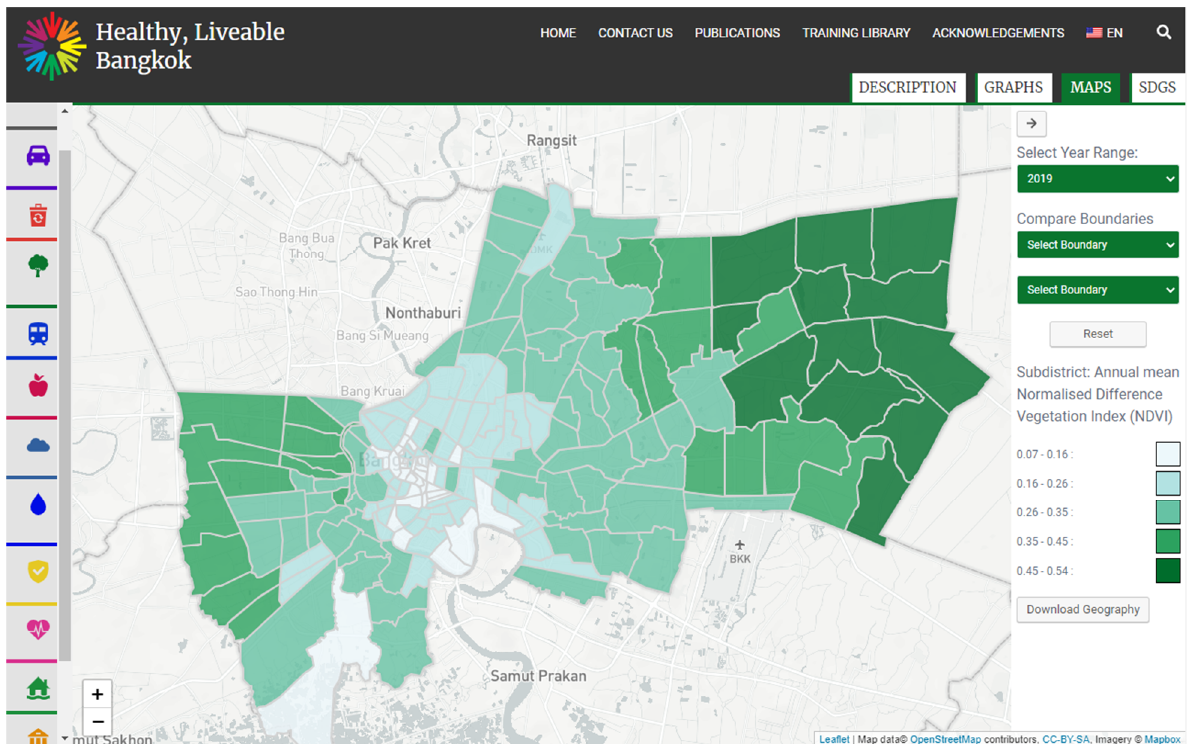
Figure 1. Interface of the partnership’s main product, a web-based liveability indicators portal. The interface allows Bangkok Metropolitan Administration officers to visualise liveability indicators mapped at the district or subdistrict (shown here) levels. Acknowledgements: Indicators site: RMIT University, 2021 [34]. Indicator data: Annual mean normalised difference vegetation index: Landsat-8 data courtesy of the U.S. Geological Survey, processed using Google Earth Engine. Subdistrict boundary data: Bangkok Metropolitan Administration (BangkokGIS). Retrieved 25 July